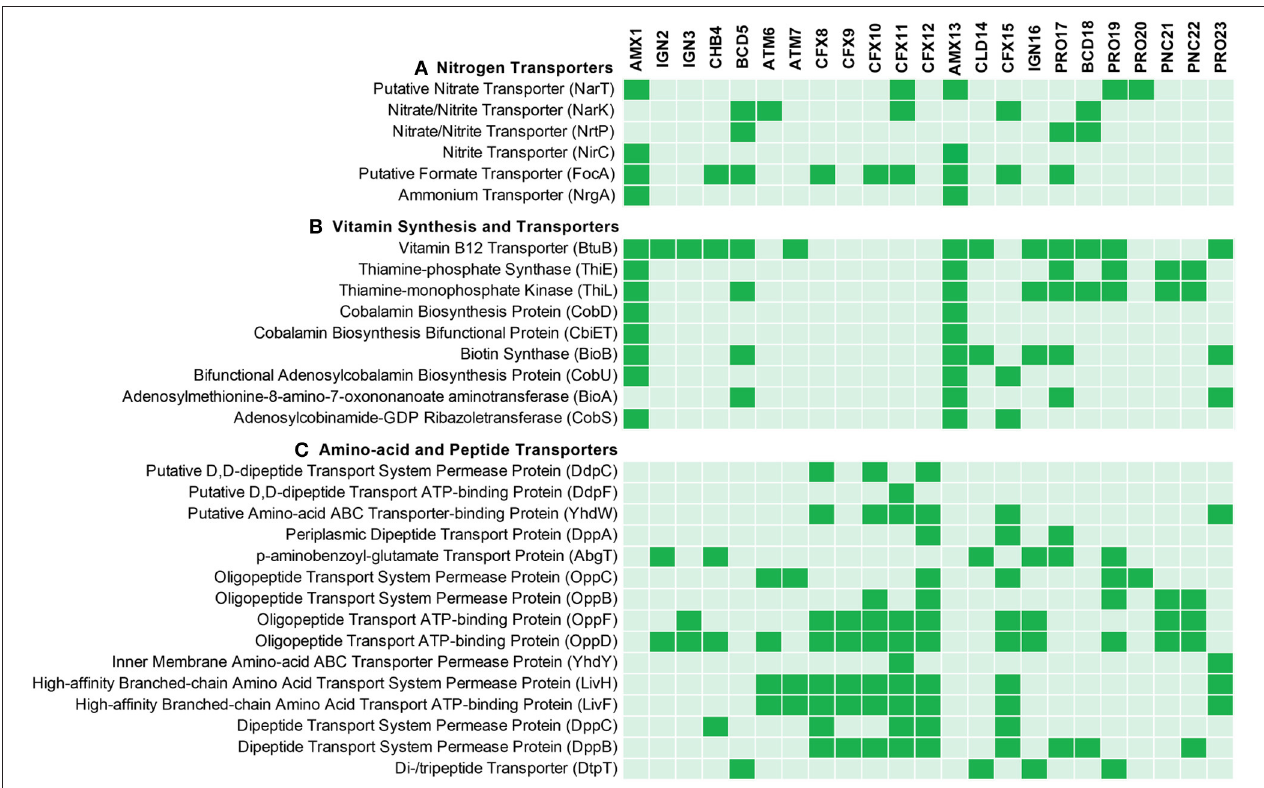
FIGURE 3 | Predicted (A) nitrogen related transporters, (B) vitamin synthesis and transporters and (C) amino acid and peptide transporters predicted across the recovered MAGs. The genomes were annotated using PROKKA and annotated genomes were processed by Roary for comparative